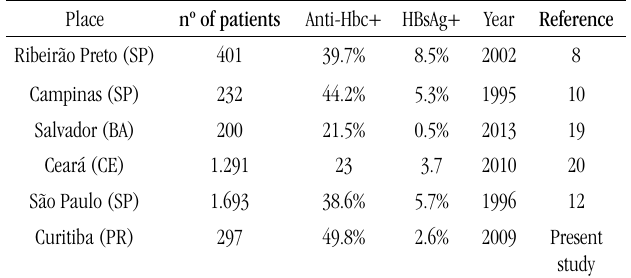
HBV: hepatitis B virus; HIV: human immunodeficiency